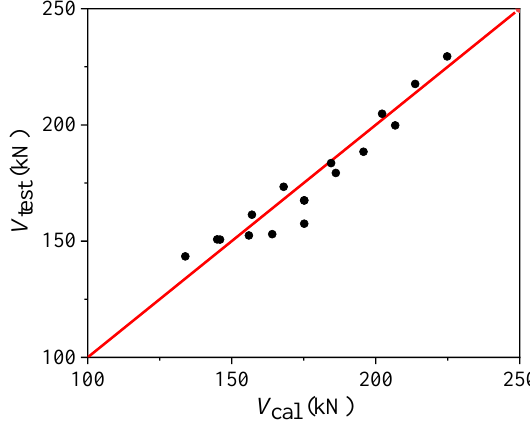
Figure 19. Comparison between V test and V cal .